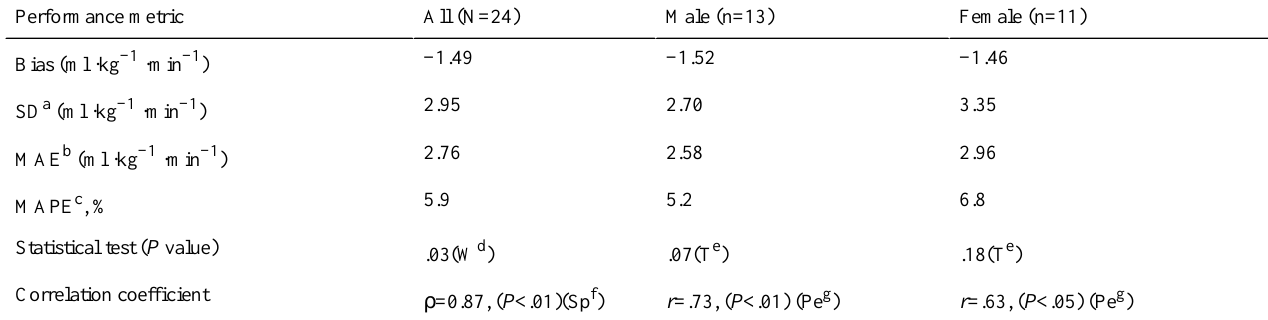
Table 4. Maximal oxygen uptake (VO 2Max ) estimated from optical heart rate data and based on an age-based maximum heart rate estimate.